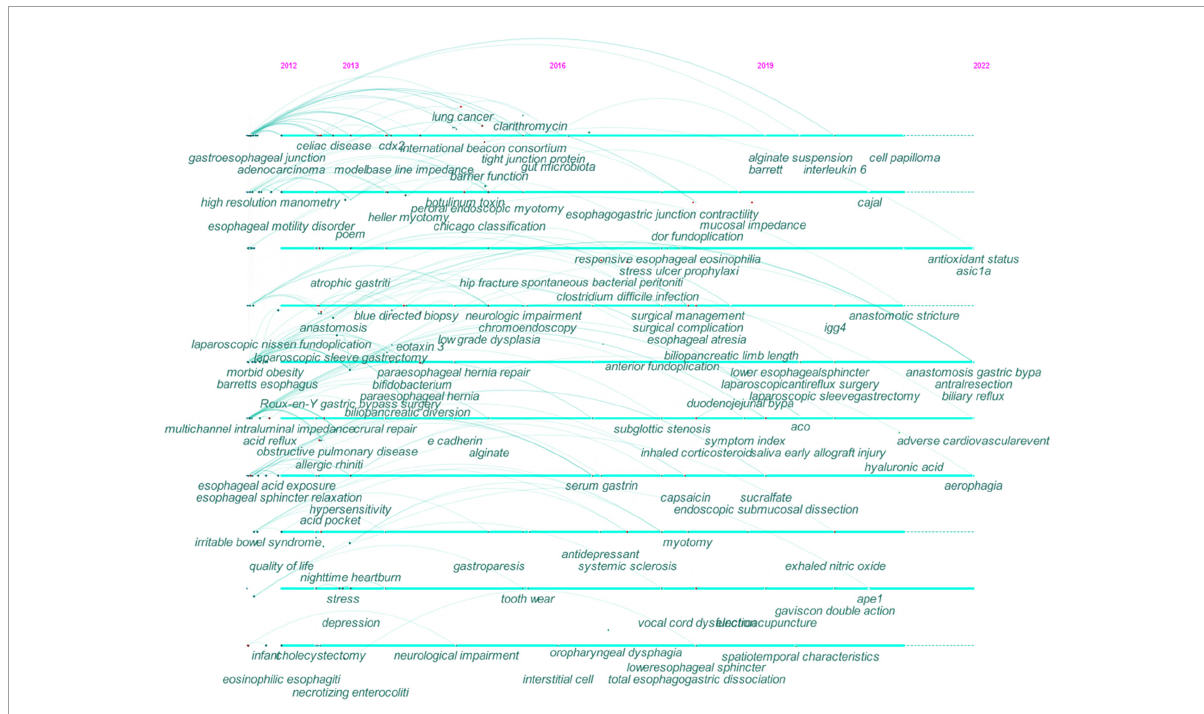
FIGURE6 Timeline view of co-occurring keywords map in GERD research. The year placed at the top of the view corresponds to the earliest year when each keyword appeared. Each node represents a keyword. The links represent the co-occurrence of keywords and the colors represent the average year of publication for each node. Each cross corresponds to the bursts of keyword